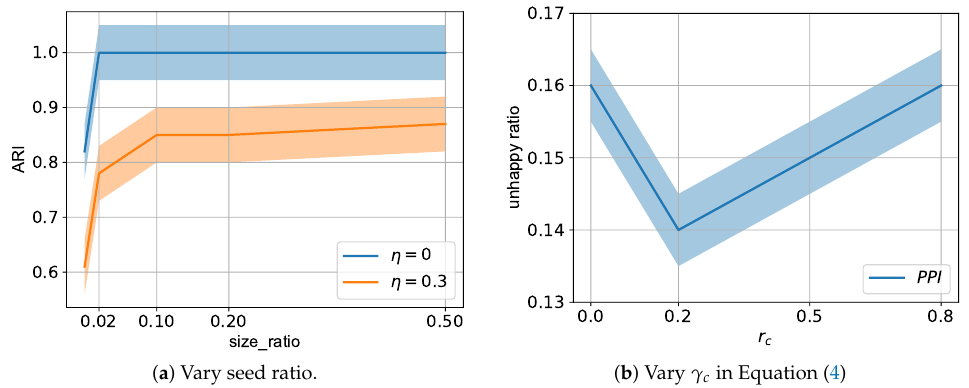
Figure 4. Hyperparametric analysis ( a , b ). Figure ( a ) in SSBM ( n = 10,000, k = 5, p = 0.01, ρ = 1.5) and Figure ( b ) in PPI network environment. Figure ( a ) compares the ARI, while Figure ( b ) compares the unhappy ratio